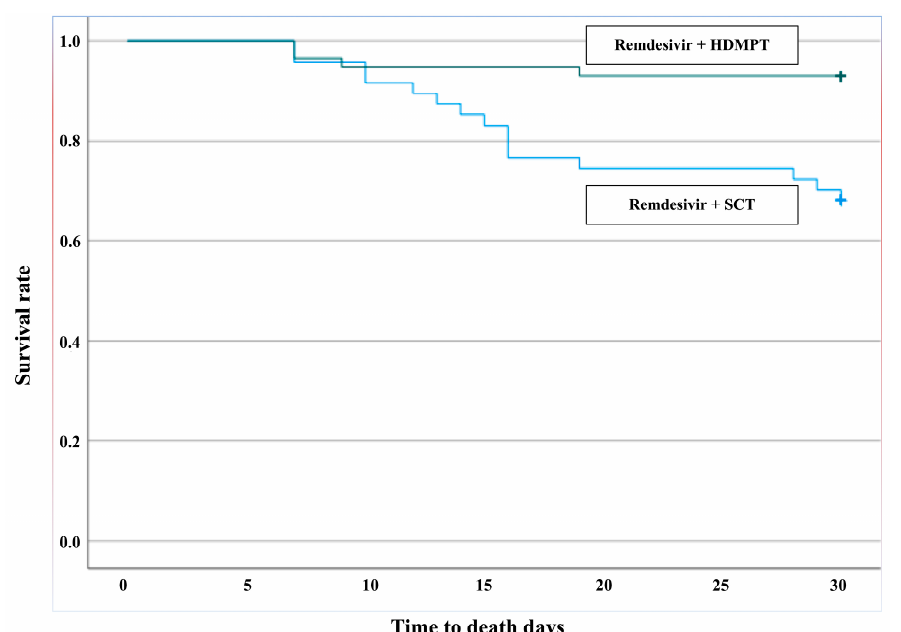
Figure 1. Kaplan–Meier estimator of the survival rate between the remdesivir plus high-dose corticosteroid pulse therapy (HDCPT) and remdesivir plus standard corticosteroid therapy (SCT) groups. Log-rank: 9.99, p = 0 .002.